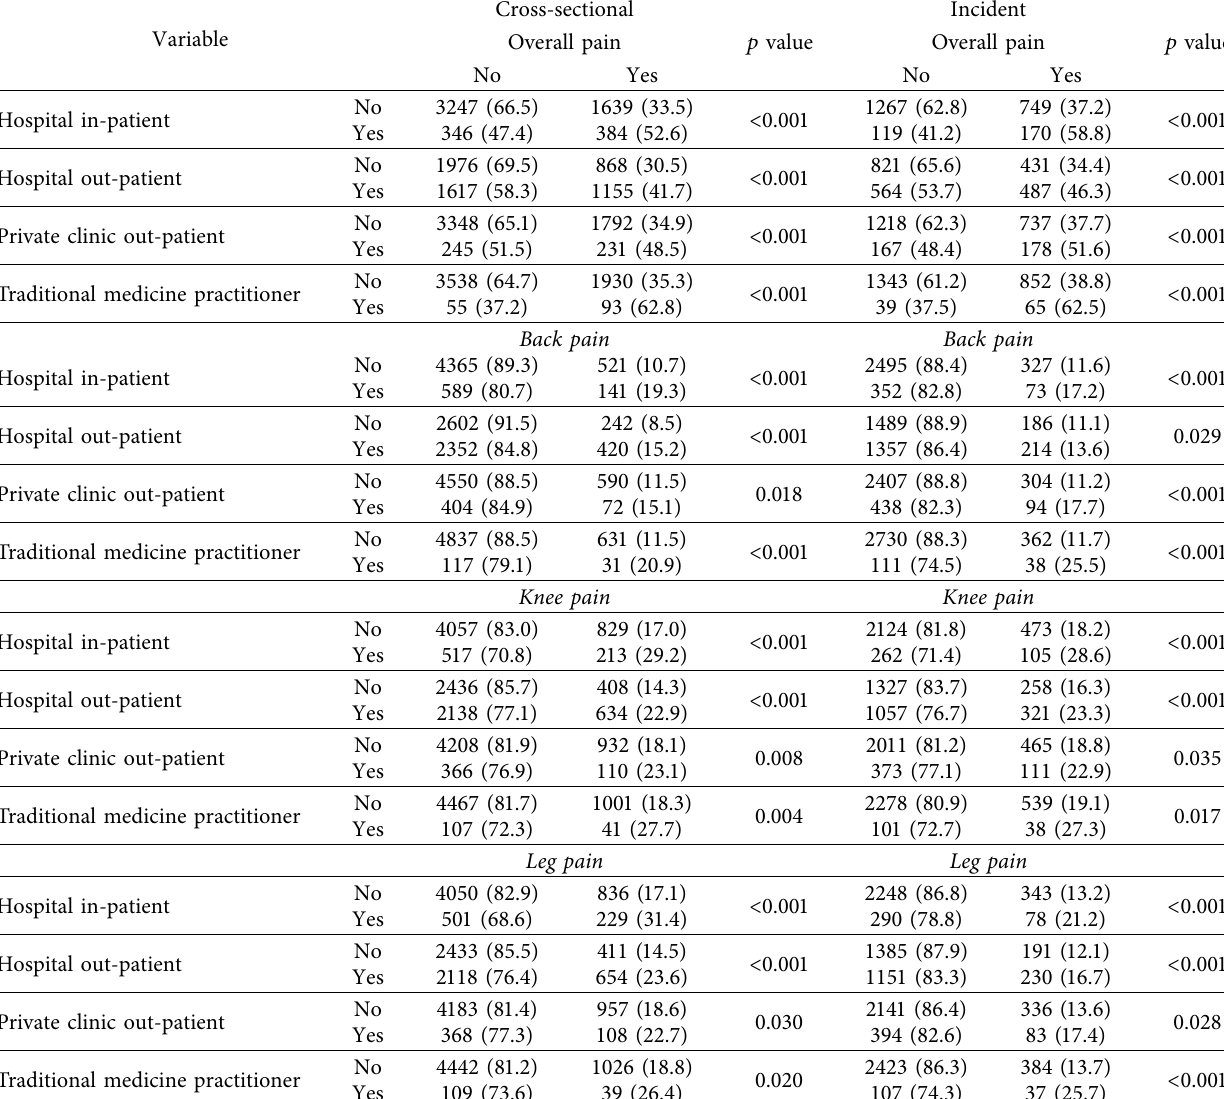
Table 2: Healthcare utilization by cross-sectional and incident pain.